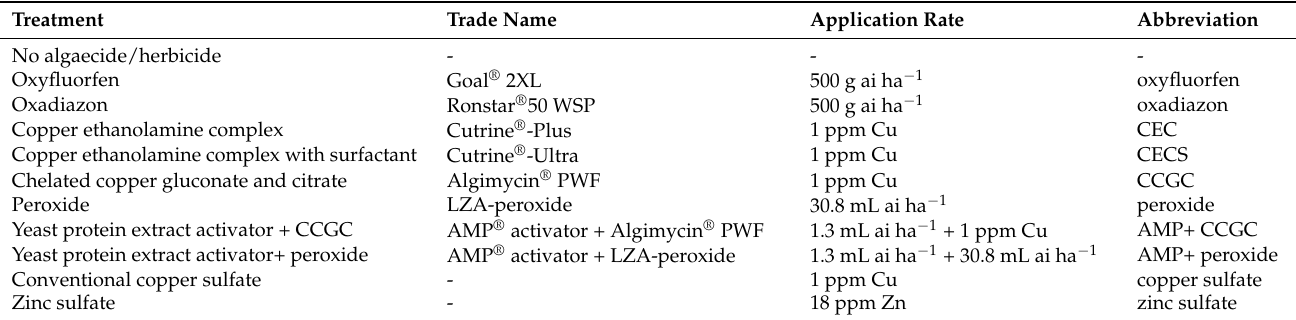
Table 1. Herbicide and algaecide treatment details and their abbreviations in the manuscript.